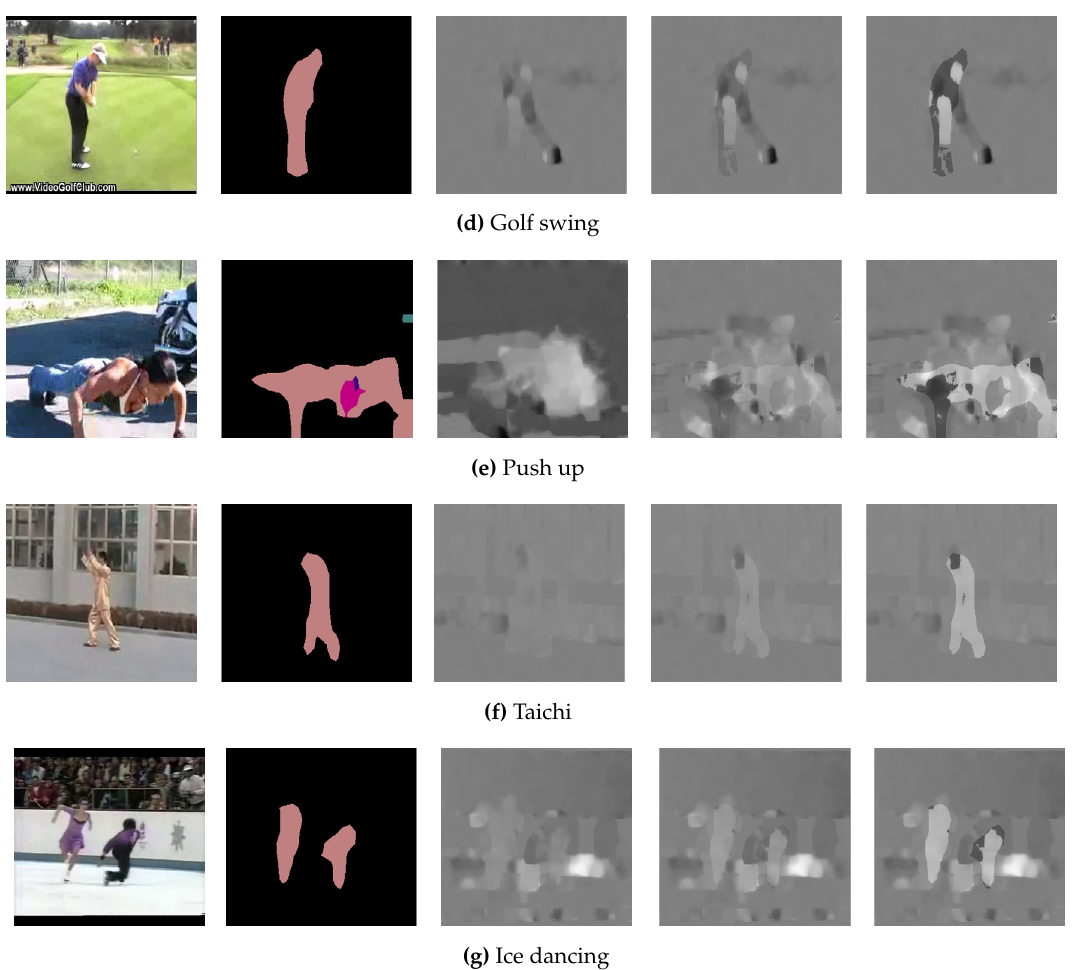
Figure 4. Enhanced images by proposed method.